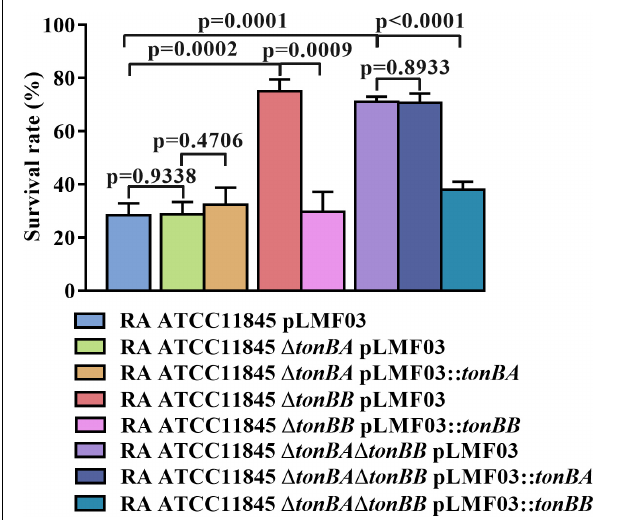
FIGURE 7 | The survival rate of R. anatipestifer ATCC11845 and its derivative strains when they were treated by streptonigrin. The bacteria were grown in the GCB medium until the exponential growth phase, then, harvested and resuspended in PBS to an OD 600 = 0.5. The final concentration of 50 ng/ml Streptonigrin was added to 1 ml of the bacterial suspension, and the mixture was incubated at 37 ◦ C for 30 min. The survival rate was calculated as described in section “Materials and